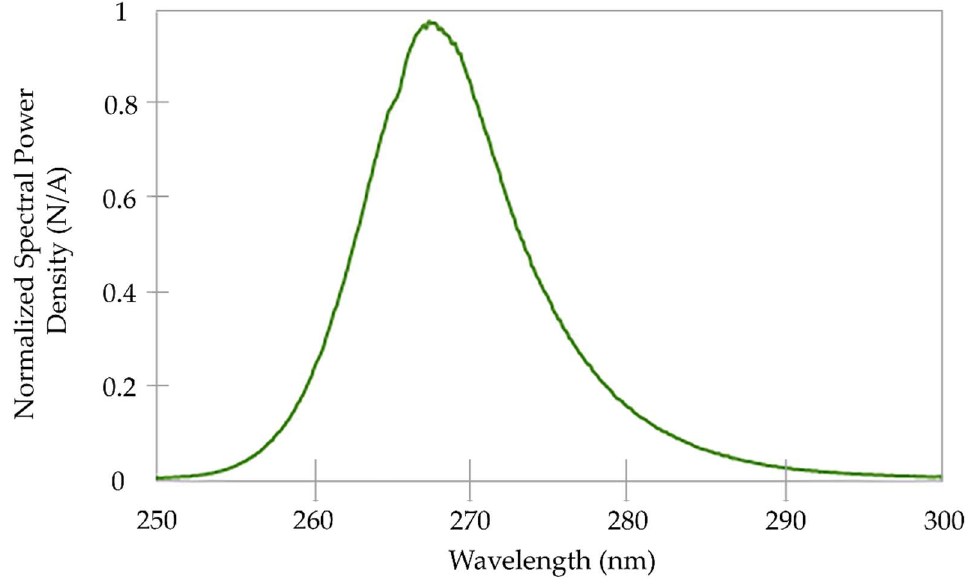
Figure 9. The spectrum of the UVC LED used for the generation of dose response curve of Bacteriophage Phi6 with peak emission of 267 nm. The representative spectrum has an FWHM of 11 nm and an asymmetric tail.